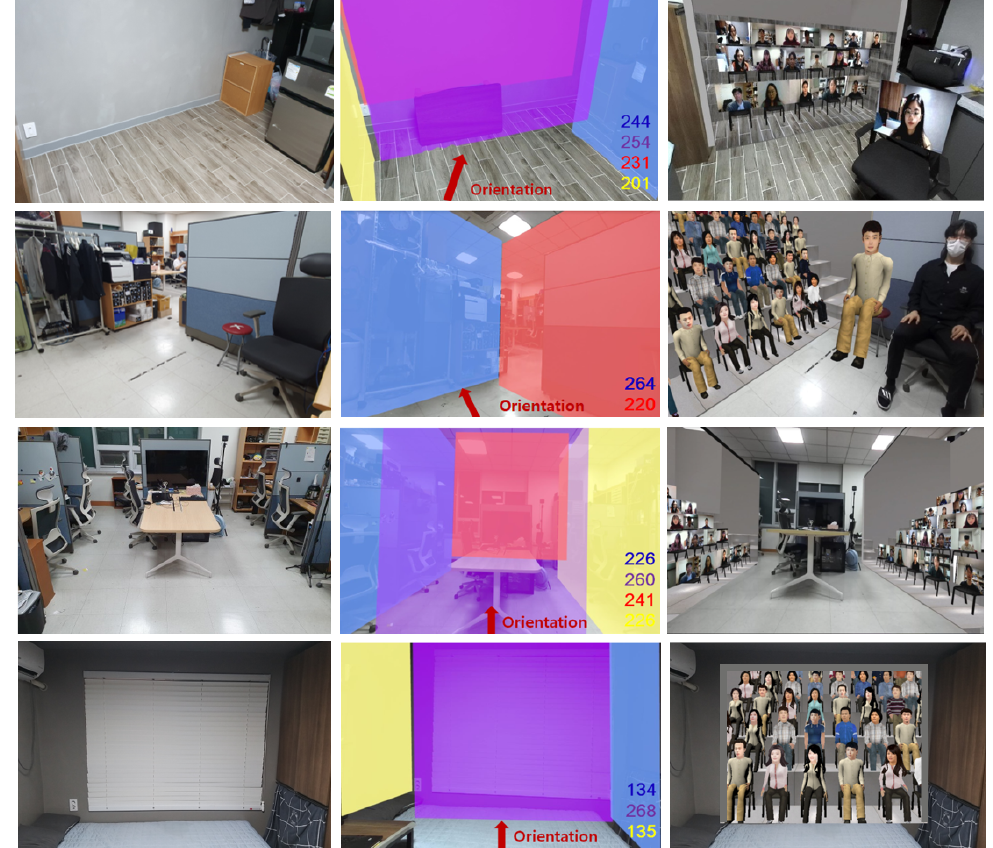
Figure 5. Four different portal selections in various local